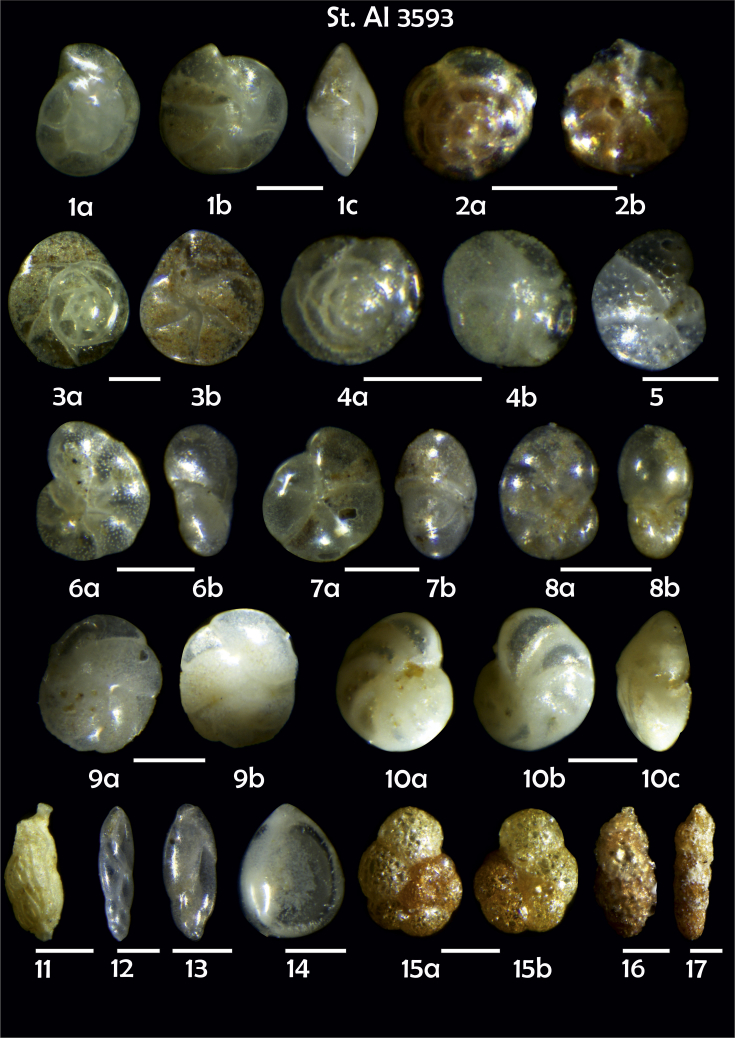
Station 35931Oridorsalis umbonatus, a spiral view, b umbilical view, c apertural view. 2Ioanella tumidula,a spiral view, b umbilical view. 3Epistominella exigua, a spiral view, b umbilical view. 4Alabaminella weddellensis, a spiral view, b umbilical view. 5Melonis sp. juvenile form? like st.3592 (9). 6Astrononion stelligerum, a side view, b apertural view. 7Pullenia quinqueloba, a side view, b apertural view. 8Nonionella auricula, a lateral view, b apertural view. 9Cassidulina laevigata, a apertural view, b lateral view. 10Cibicidoides wuellerstorfi, a umbilical view, b spiral view, c apertural view. 11Trifarina angulosa.12Fursenkoina complanata. 13F. fusiformis. 14Fissurina sp. 15Trochammina inflata. 16Karrerulina sp. 17Karrerulina conversa. Scale 100 μm.